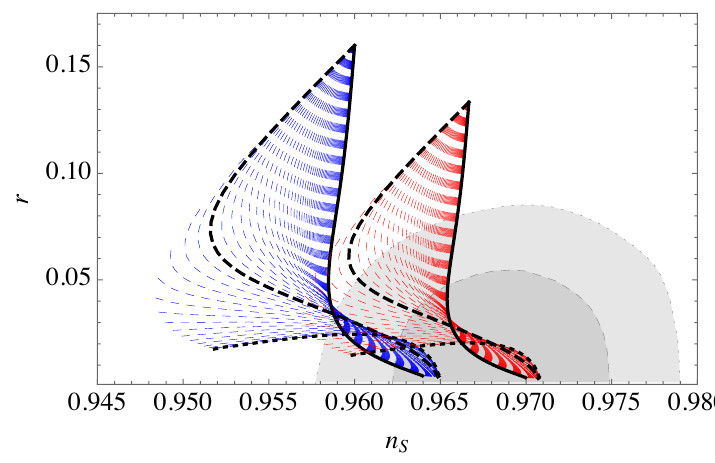
Figure 5 . Impact on the scalar spectrum index n S and the tensor-to-scalar ratio r for the (cid:30) 2 in(cid:13)ation model with (cid:22) from 0 to 100 H and m from 0 to 6 H , and ( (cid:22) 2 + m 2 ) 1 = 2 > 3 H= 2. The blue and red regions are for N cmb = 50 and 60 respectively. The dotted, dashed and solid curves are for m (cid:12)xed to be 0 ; 3 H= 2 and 6 H respectively. The gray regions are the one-sigma and two-sigma constraints from the combination of the Planck data and the BICEP2/Keck data